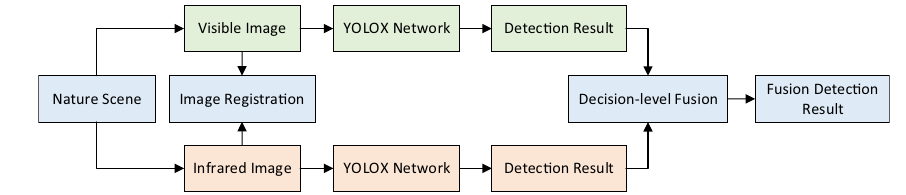
Fig. 4 Decision-level fusion network